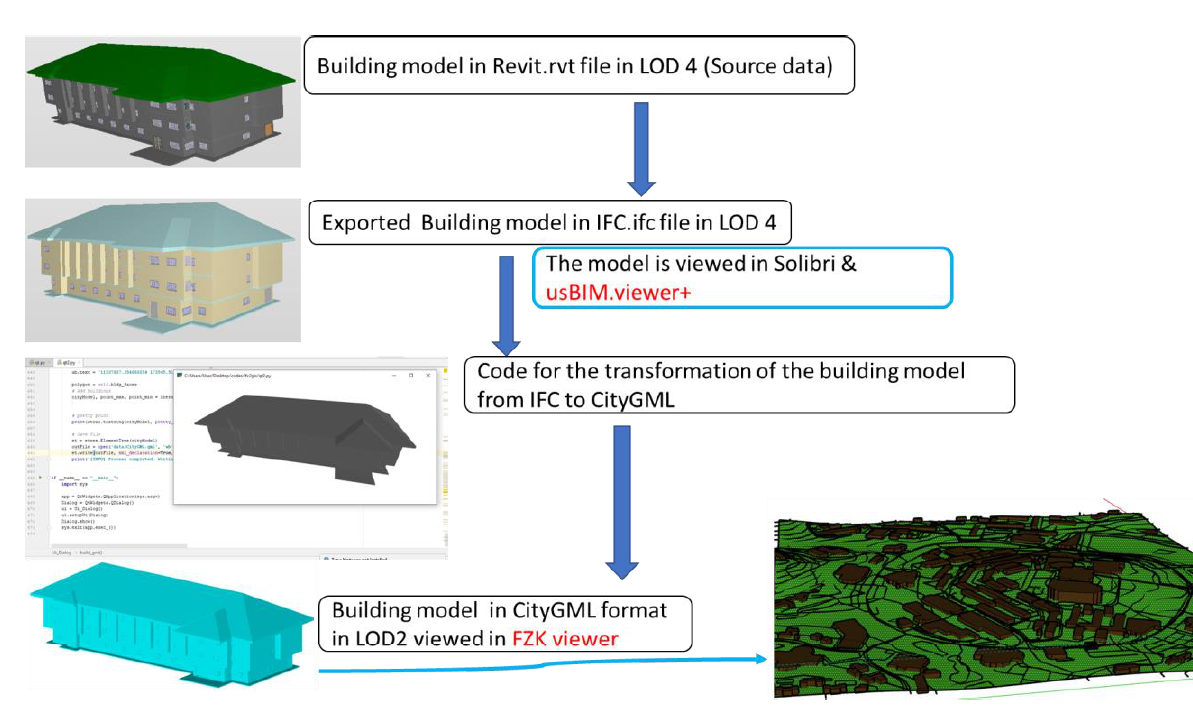
Figure 4 . Result of IFC to CityGML